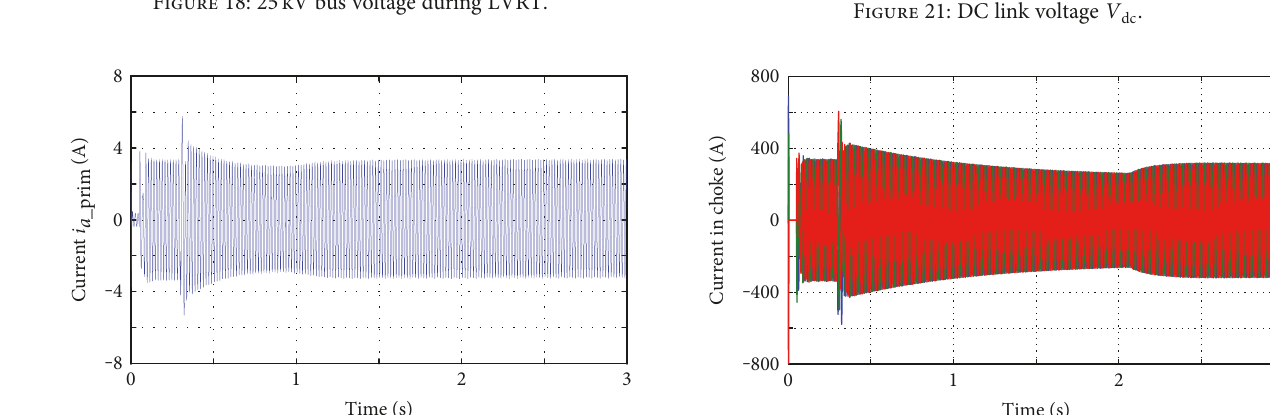
Figure 18: 25 kV bus voltage during LVRT.